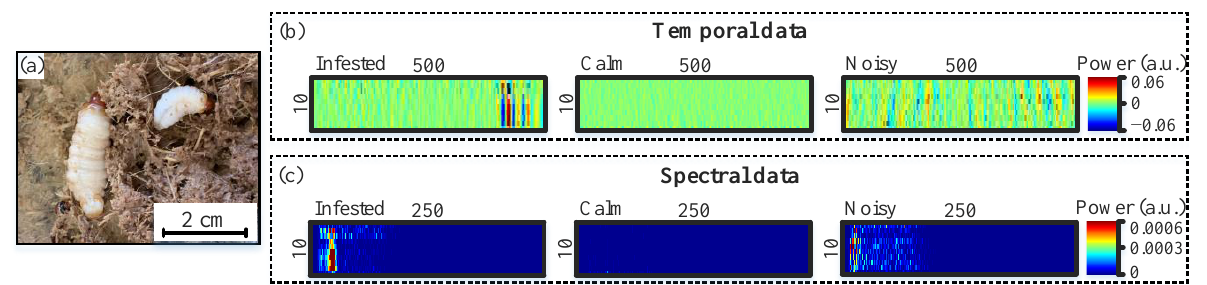
images for the CNN models when using the “infested”, “calm”, and ”noisy” temporal data and their corresponding spectral images, respectively.